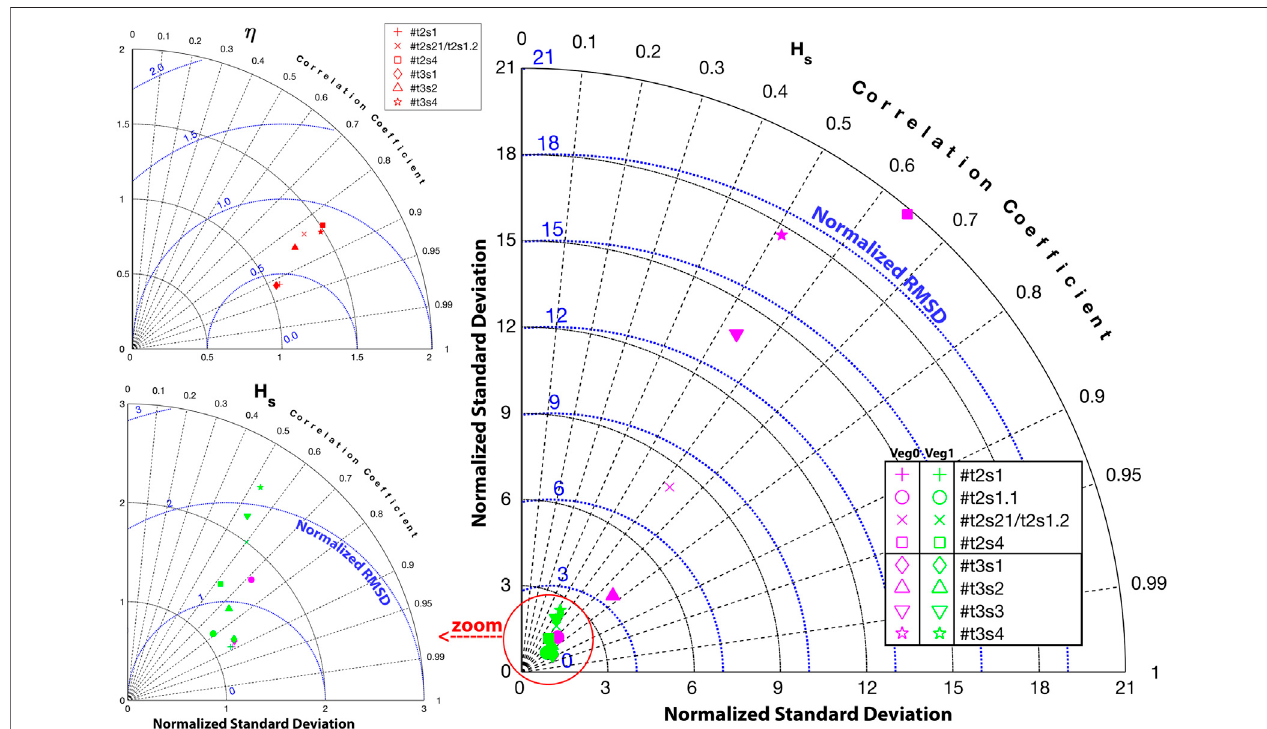
FIGURE 9 | Taylor diagrams for water level ( η : top left); and signi fi cant wave height ( H s : right and bottom left (zoom in) representing modeled and collected data at gauges locations (red: ADCIRC; magenta: WW3 without wave – vegetation interaction; and green: WW3 with wave – vegetation interaction) in terms of the Pearson correlation coef fi cient, the normalized root mean square deviation (RMSD), and the normalized standard deviation σ .